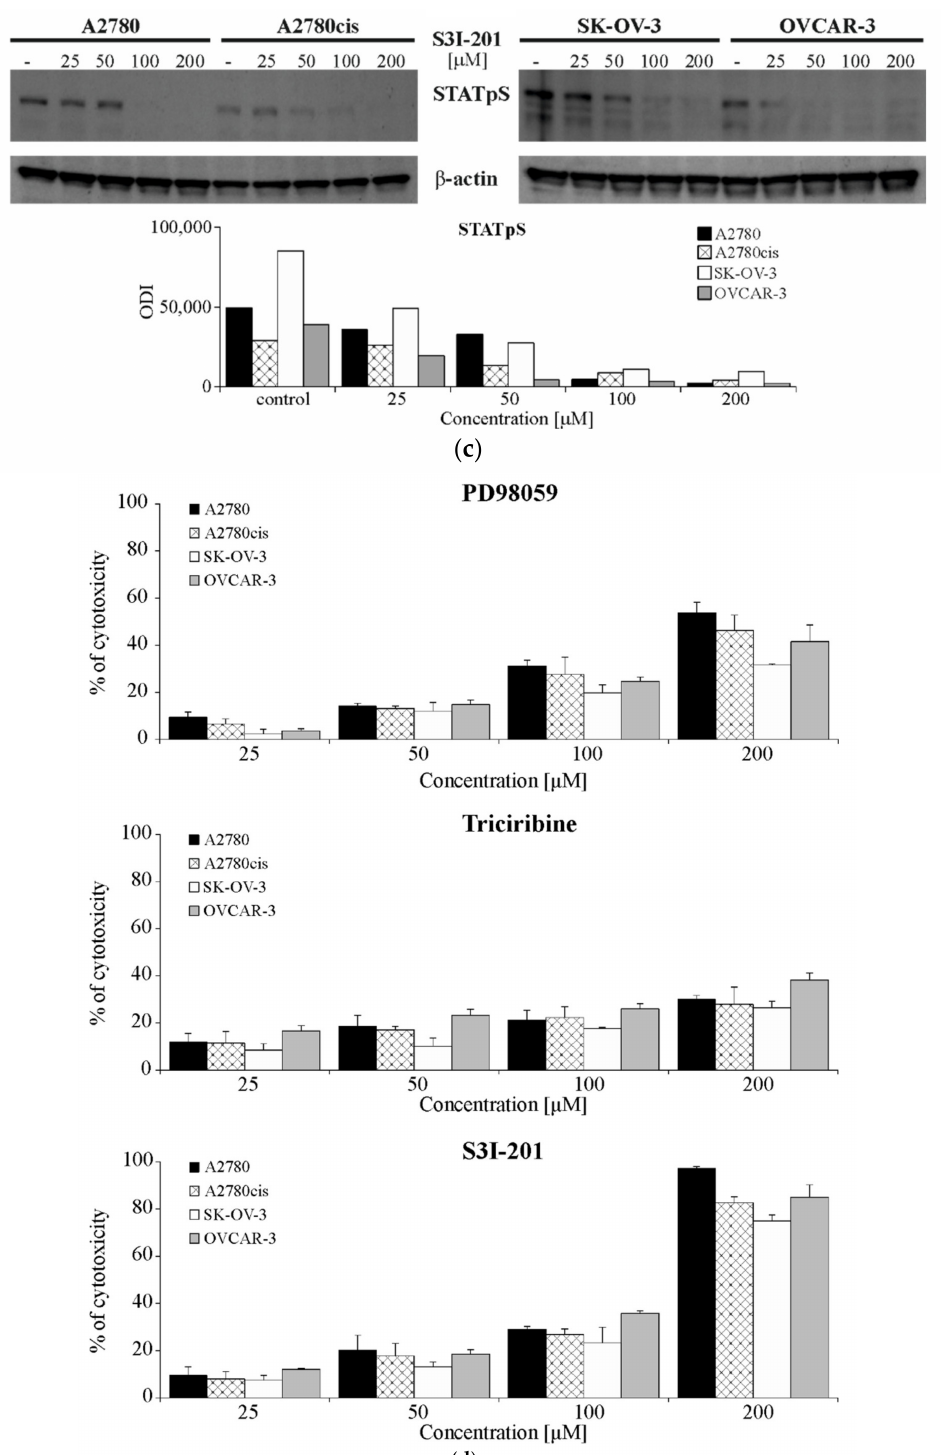
Figure 6. Determination of effective concentration of PD98059, Triciribine and S3I-201. All cell lines were cultured with PD98059 [25–200 µ M] or Triciribine (10–200 µ M) or S3I-201 (25–200 µ M) or not (control) for 48 h. ( a – c ) The phosphorylation level of signaling proteins was determined with Immunoblotting-ECL method. Representative immunoblots of ERK 1/2 ( a ) or AKT ( b ) or STAT3 ( c ) phosphorylation, along with β -actin level are presented. Bands were quantified by densitometric analysis and data are presented as the optical density intensity (ODI) of the area under each band’s peak two independent experiments ( n = 2). ( d ) Cell viability was determined with MTT assay and is presented as the mean percent of cytotoxicity ± SD calculated from three independent experiments ( n =